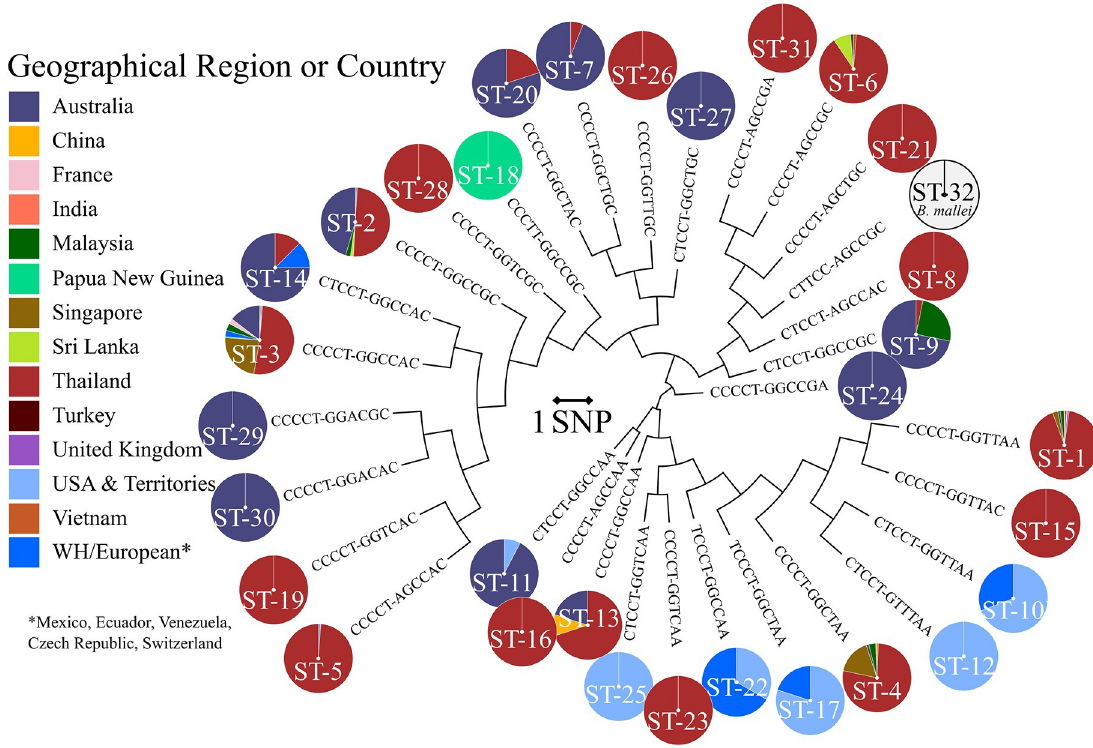
Fig 3. DLST SNP-based phylogeographic tree for the expansive set of B . pseudomallei (n = 1,442, sequence types 1 to 31) and B . mallei (n = 81, sequence type 32). B . pseudomallei strains are color-coded by geographic origin. Western Hemisphere (WH), asterisk indicates WH and European countries Mexico, Ecuador, Venezuela, Czech Republic, and Switzerland.